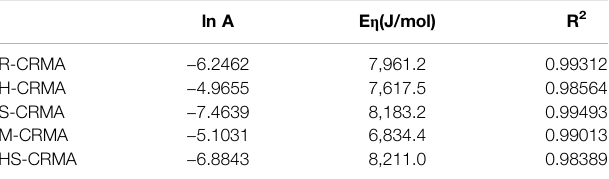
Frontiers in Materials |